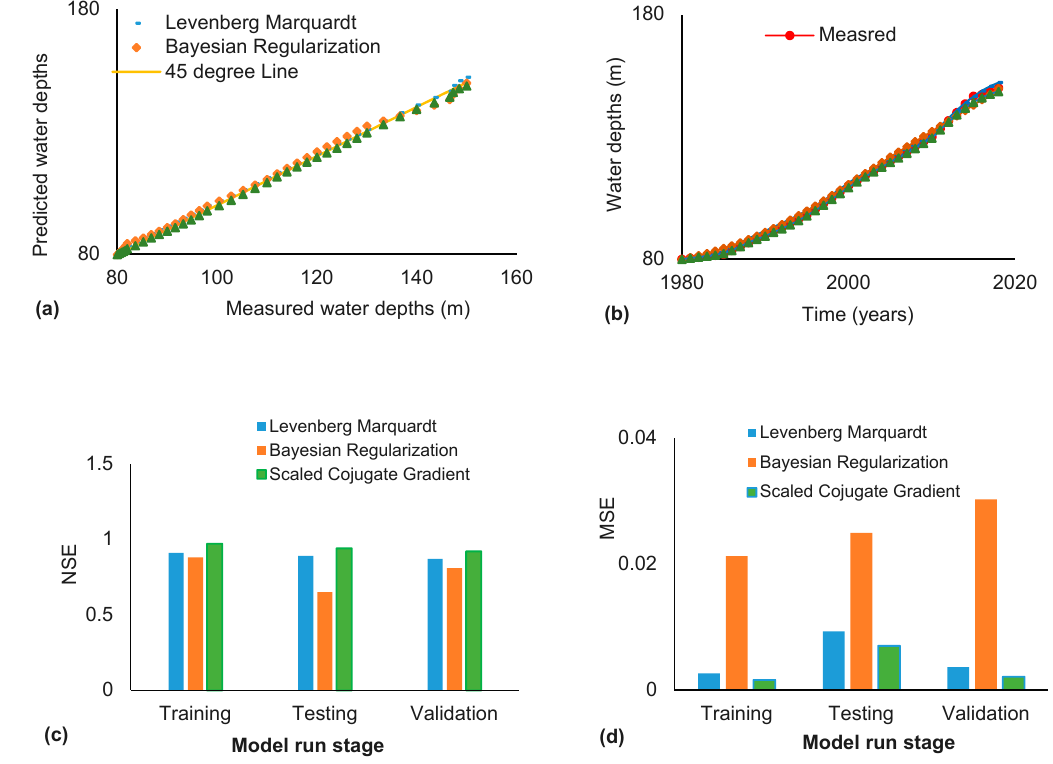
Figure 10. Comparison of ANN results for two- and three-layer architecture models with 10 neurons in each layer; ( a ) MSE values, ( b ) NSE values.